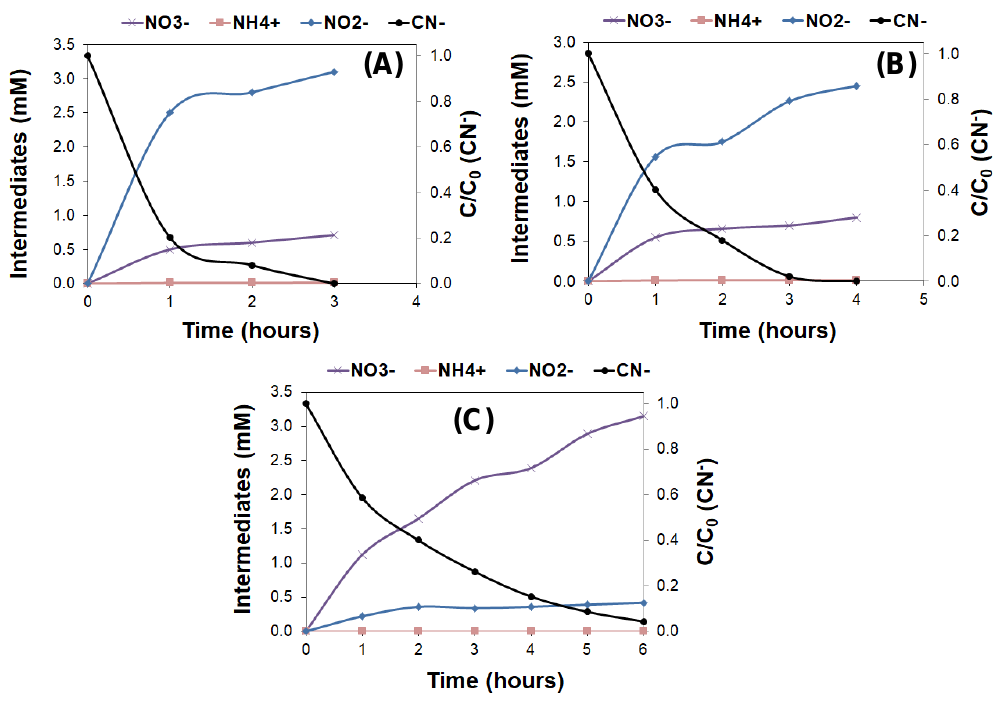
Figure 3. Evolution of the concentration of cyanides (left axis) and intermediates (right axis) upon illumination of a synthetic solution of 100 mg / L of KCN with various light sources. ( A ) UVC lamp; ( B ) UV-Vis lamp; ( C ) SimSolar lamp.